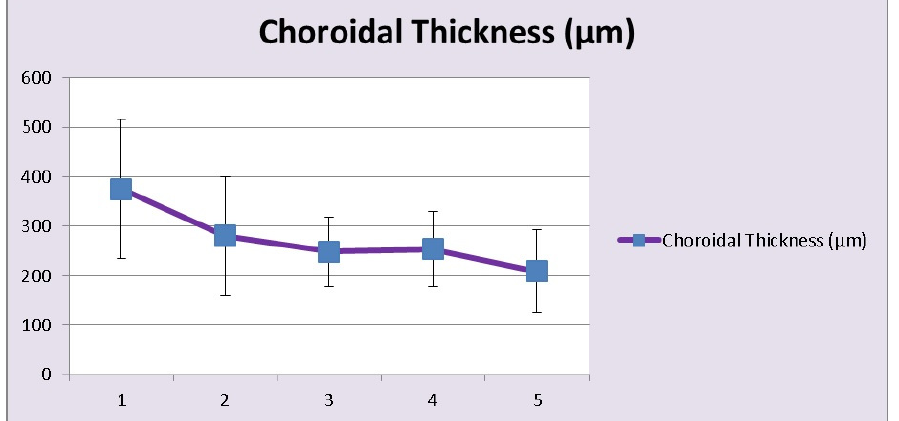
Figure 8. HLA-A29 birdshot retinochoroiditis; EDI-OCT. Substantial thickening of the choroid in an initial-onset BRC.